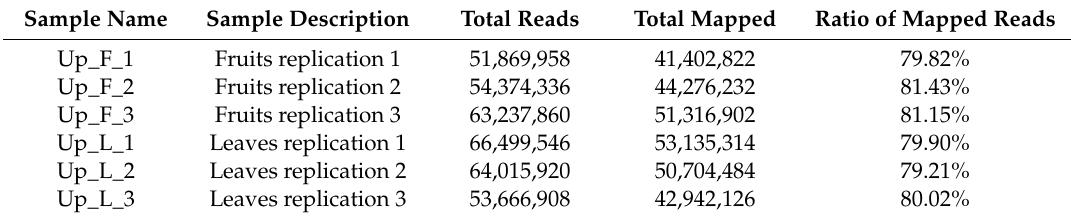
Table 1. Summary of mapping transcriptome reads to reference sequence in elm ( Ulmus pumila